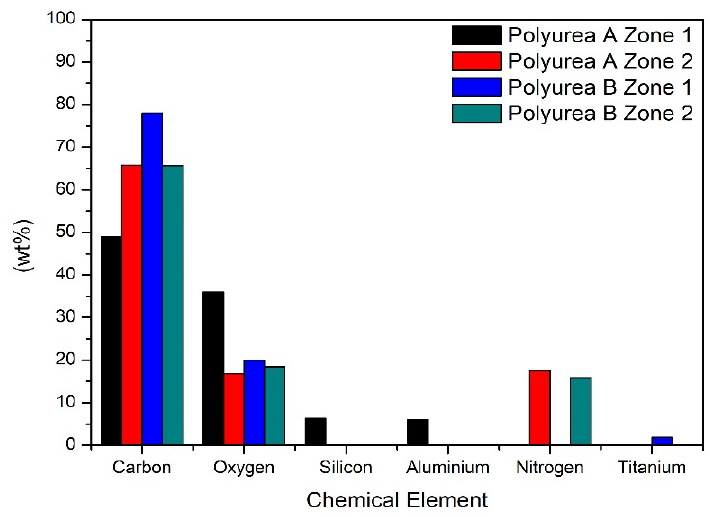
Figure 7. Comparison of the chemical composition of polyureas A and B obtained from the EDX technique.